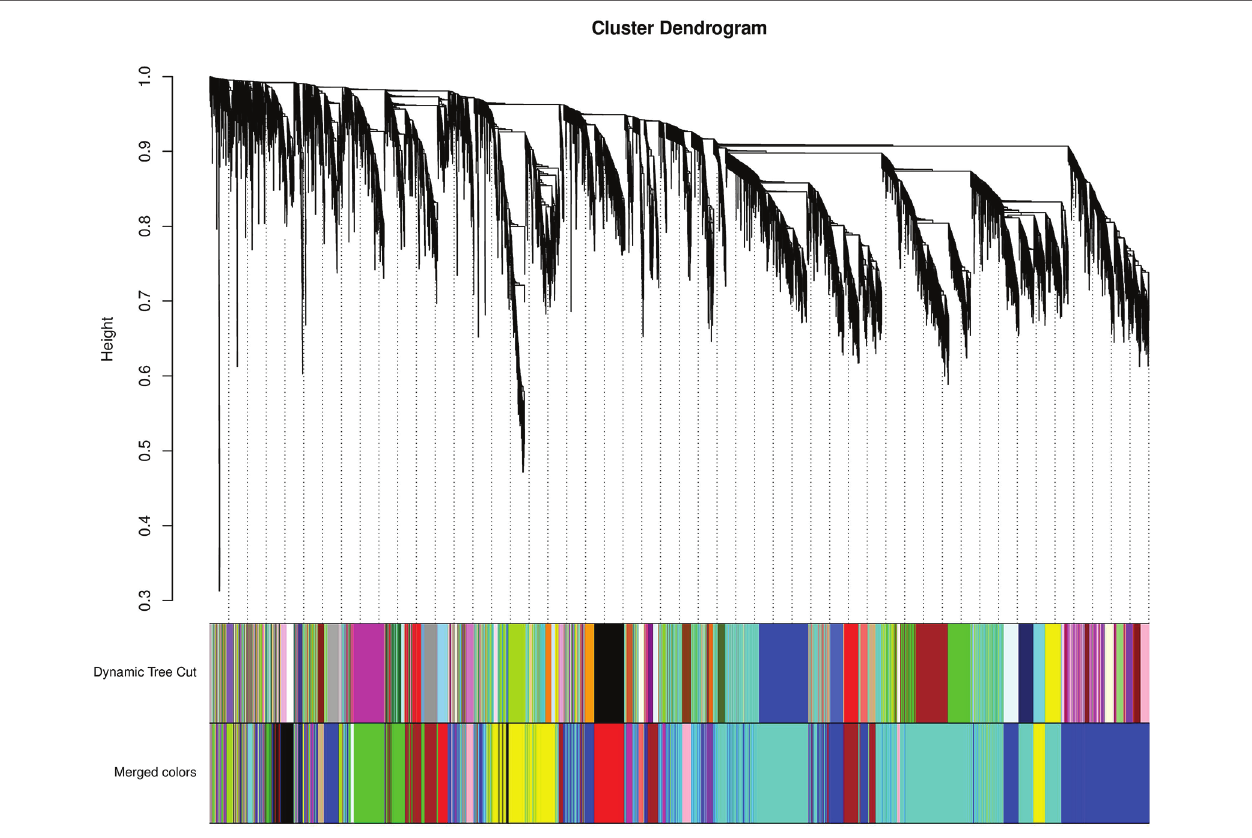
FIGURE 5 | Cluster dendrogram of differentially expressed mRNAs. Upper portion of the figure is the gene cluster tree. A leaf represents a gene while the branches represent different gene modules. Different colors in the middle portion of the dynamic tree cut represent different modules. Merged colors (lowermost portion) represent the merged modules calculated when the dissimilarity coefficient < 0.25. Yellow tree represents Module-FASN (“ME-FASN”) module; Blue tree represents Module-RPL (“ME-RPL”) module; Turquoise tree represents Module-SLC (“ME-SLC”)